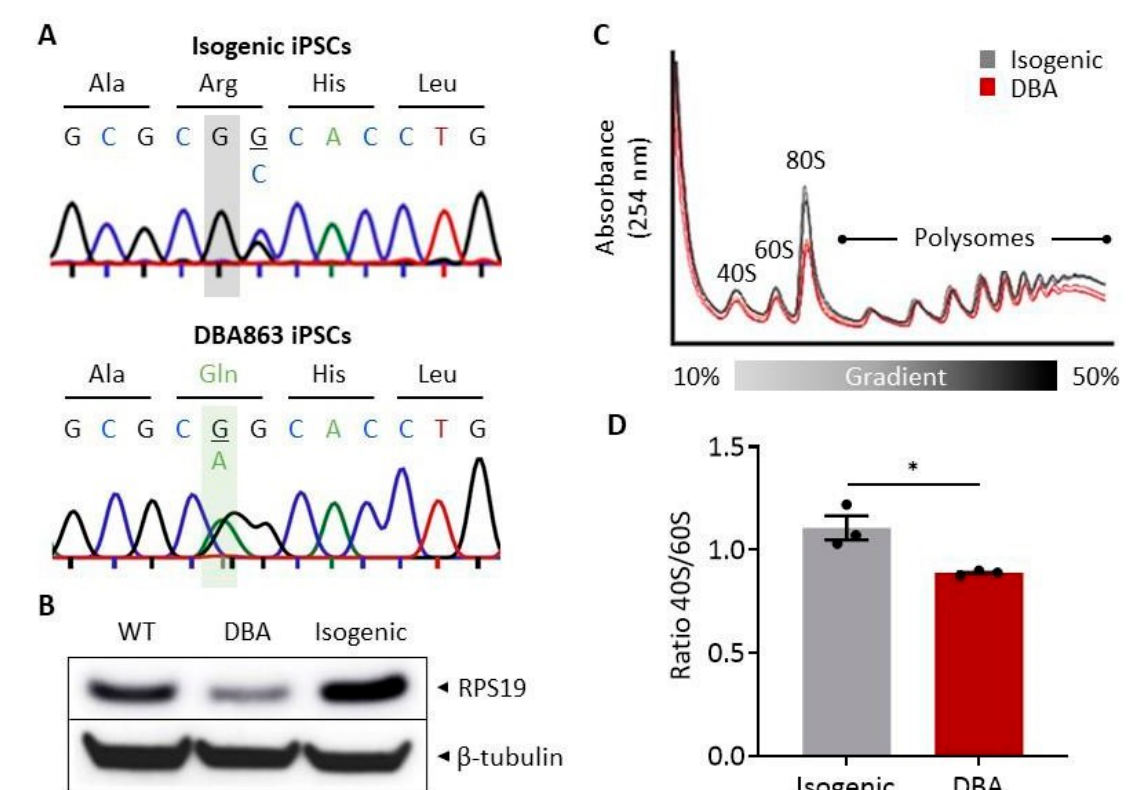
Figure 1. Generation and characterization of isogenic and DBA iPSCs. ( A ) Genomic RPS19 sequence trace chromatograms for isogenic (top panel) and DBA863 (bottom panel) iPSCs to confirm CRISPR/Cas9-mediated correction (grey highlight) of heterozygous c.185G>A (pR62Q) nonsense mutation (green highlight). In isogenic iPSCs, the overlapping G/C bases represent a silent mutation introduced in the template DNA during genome editing to complete an AscI restriction site (GGCGCGCC) for rapid RFLP screening of RPS19 gene corrected iPSC clones. ( B ) Western blot for RPS19 and β -tubulin loading control for wild-type (WT), DBA and isogenic iPSCs. ( C ) Sucrose gradient (10–50%) polysome profiling analyses for isogenic and DBA iPSCs. Peaks represent ribosomal subunits (40S and 60S), 80S monosomes, and ribosome clusters (polysomes). ( D ) Calculated 40S/60S ratios for isogenic and DBA iPSCs. Data are presented as mean ± standard error of the mean (SEM). Unpaired t -test, * p ≤ 0.05 ( n = 3).